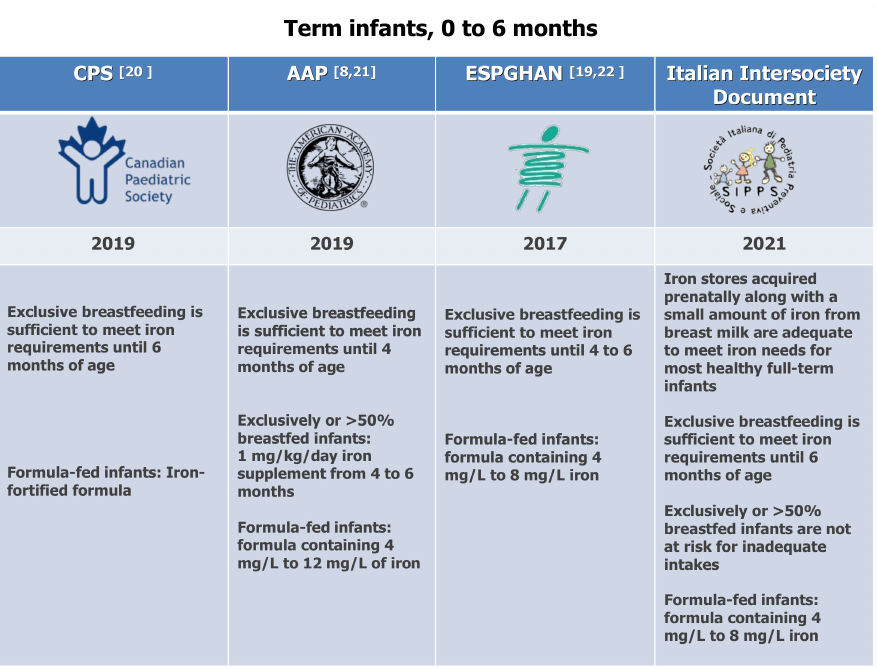
Figure 1. Dietary recommendations for term infants, 0 to 6 months. CPS [20], AAP [8,21], ESPGHAN